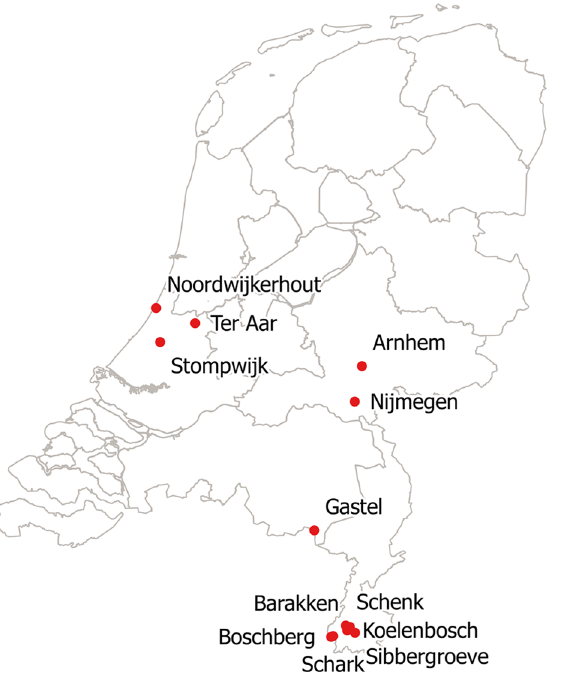
Fig 1. Catching sites of Campylobacter -positive bats in the